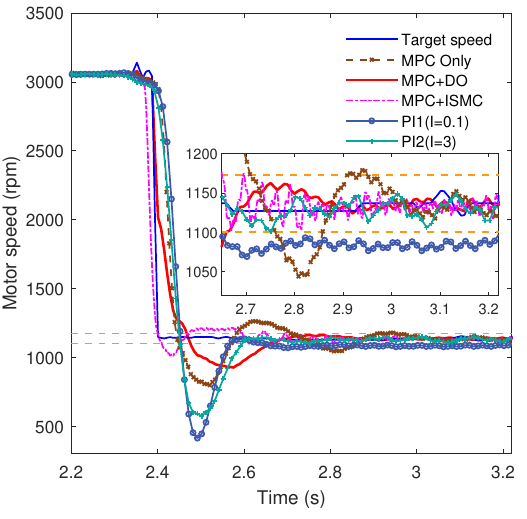
Figure 11. Experiment results for different methods. Table 4. Speed fluctuation range of different